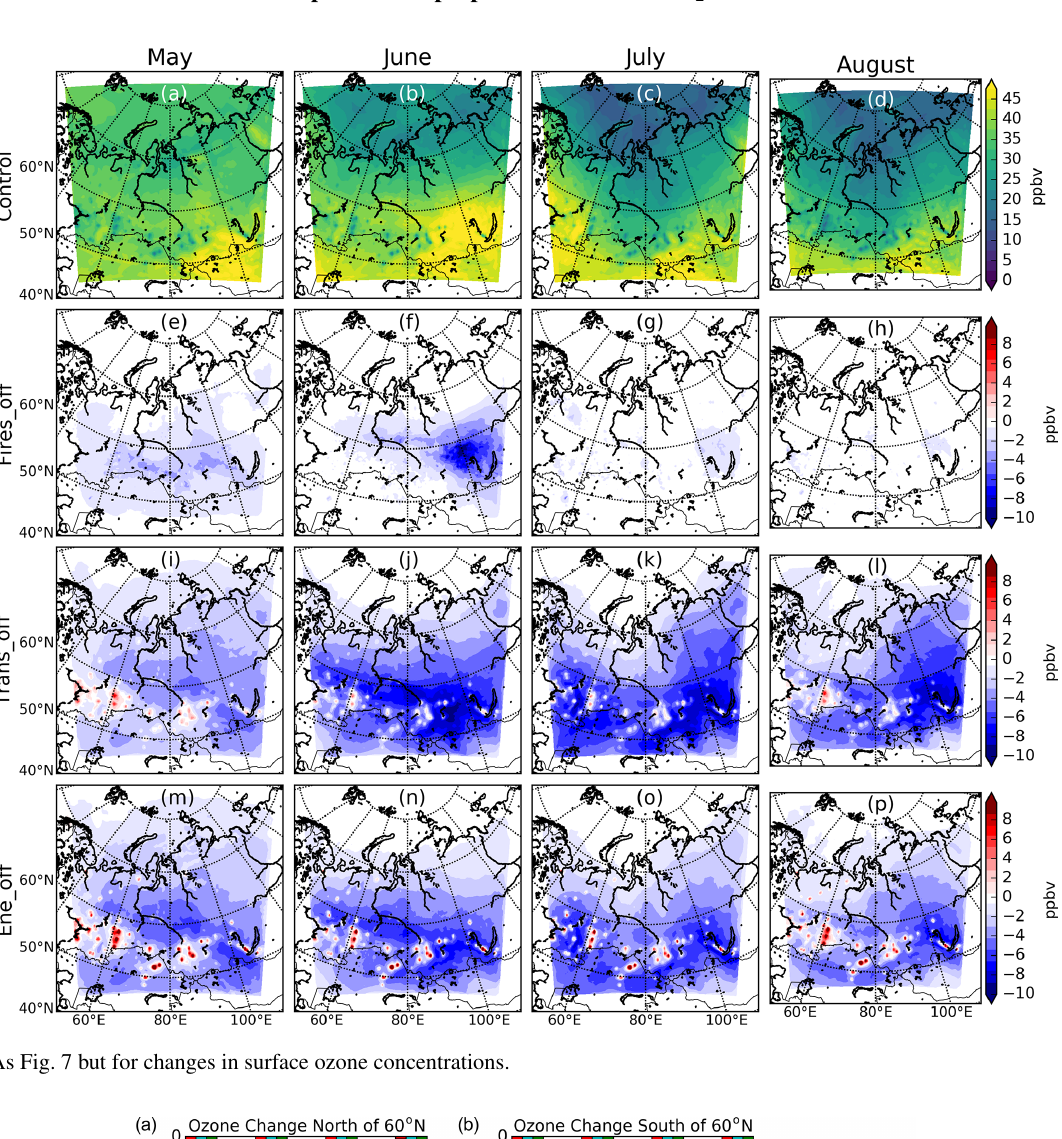
Figure 8. As Fig. 7 but for changes in surface ozone concentrations.